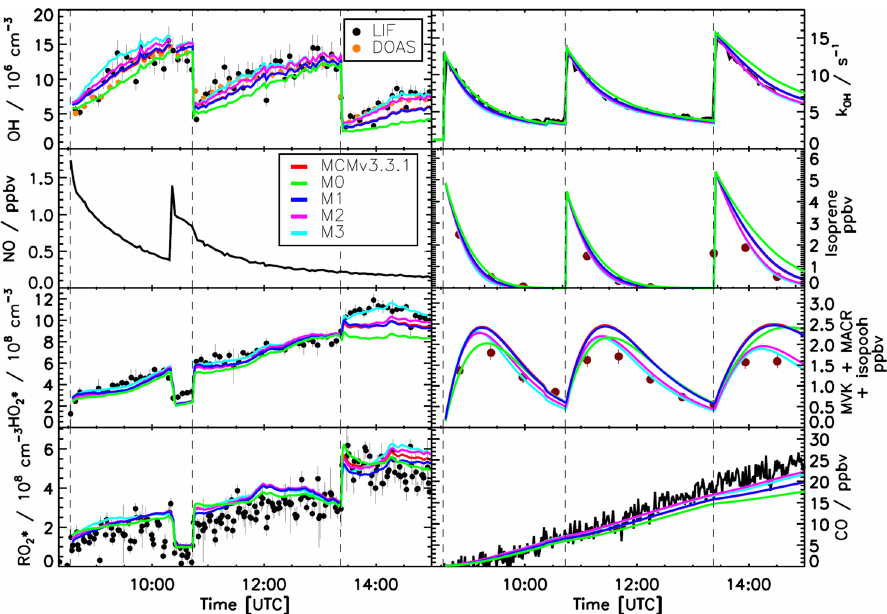
Figure 6. Comparison of modelled and measured trace gases for an experiment with variable NO concentrations, 1 . 5 > NO > 0 . 2ppbv. Measured time series of radicals and OH reactivity (LIF), isoprene and MVK + MACR + ISOPOOHs (GC), and CO (Picarro) are compared to model calculations. Vertical dashed lines indicate the times when isoprene was injected. All models are able to reproduce the observed trace gases within their uncertainties for NO > 0 .